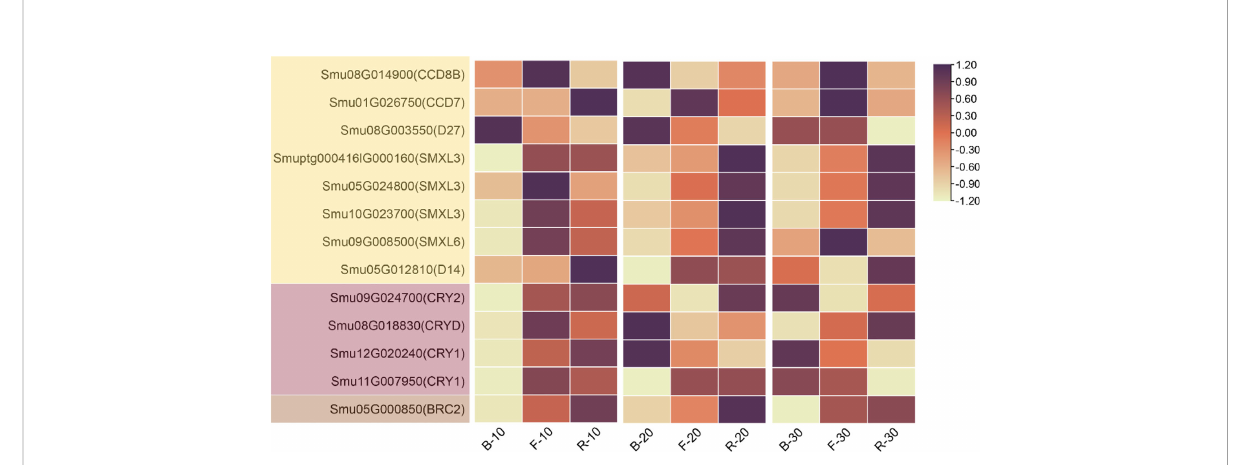
FIGURE 5 Heat map of CCD , SMXL , D27 , D14 , CRY , and BRC2 expression under different periods of light quality